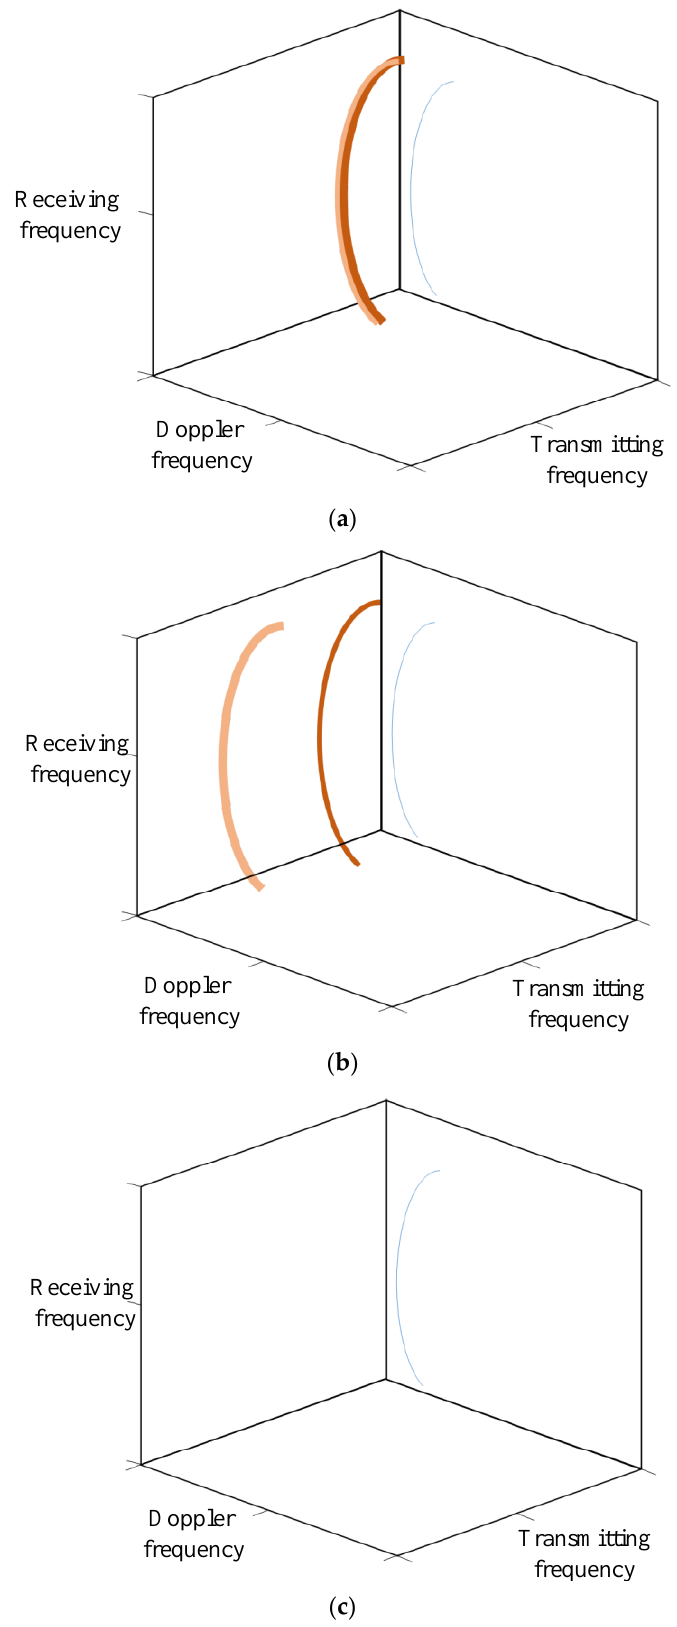
Figure 6. D domain clutter power spectrum diagram. ( a ) MIMO; ( b ) FDA; ( c ) MLC FDA.